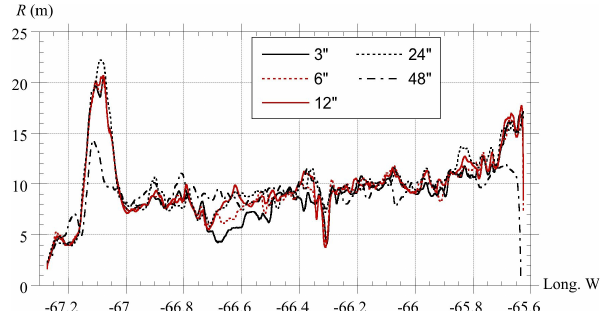
Fig. 10. Maximum runup (in meter) along PRNS, for cases in Figs. 7 and 9. For clarity, all solid lines denote smoothed curves based on raw computational data (not shown).